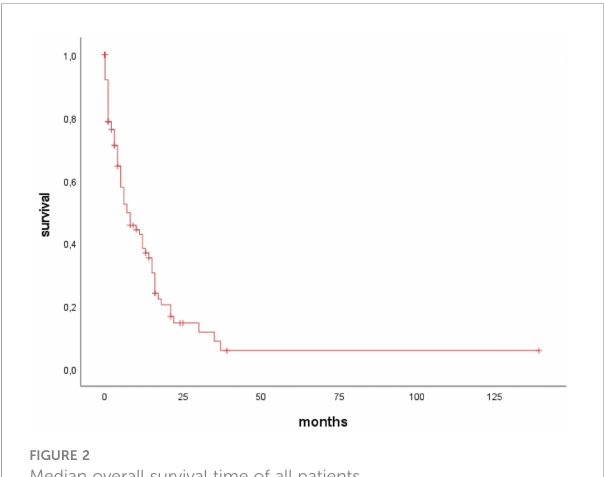
FIGURE 2 Median overall survival time of all